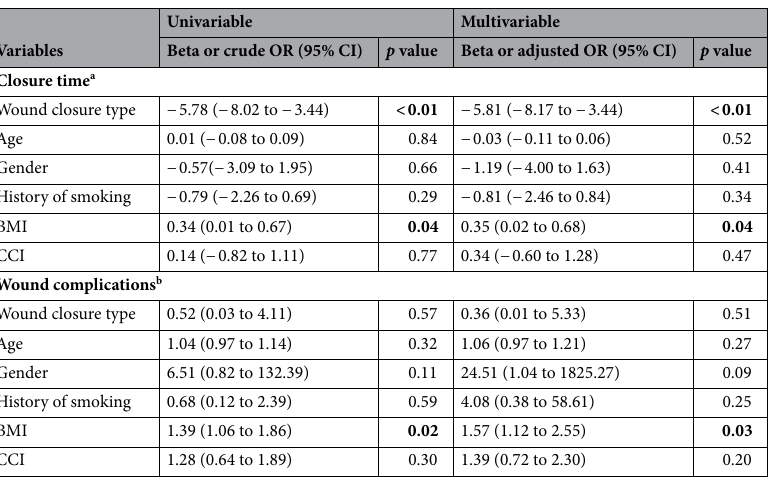
Table 5. Multiple regression analysis for the closure time and wound complications. Significant values are in